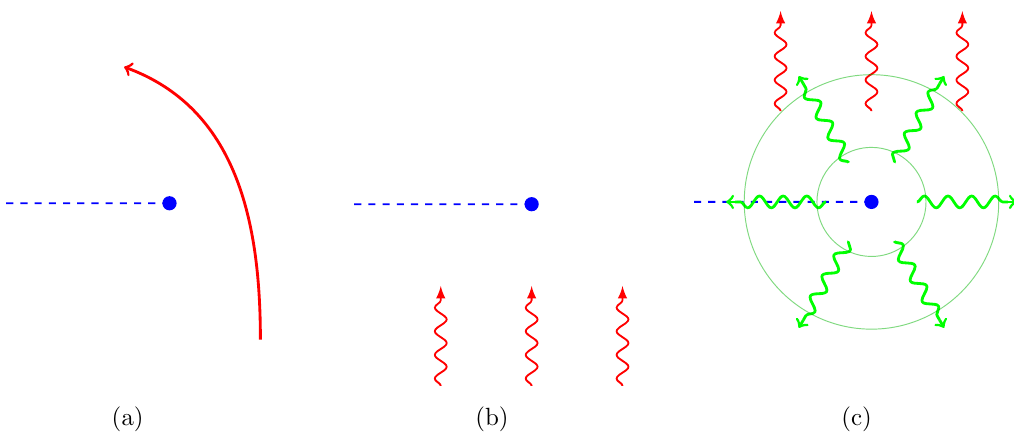
Figure 3. Free particles/fields (red) scattering around a cone geometry (blue). The cone is represented in blue, with a dashed blue branch-cut representing the lack of periodicity under φ 2 π . (a) Deflection of the trajectory of a classical particle that propagates freely in the conical deficit geometry. (b) Quantum wave-packets approach the cone source at t = the presence of the conical deficit. (c) As the waves interact with the source of the cone, they scatter. Parts remains a plane-wave (red) that ignore the non-trivial geometry, while some of the wave scatters spherically (green) away from the location of the